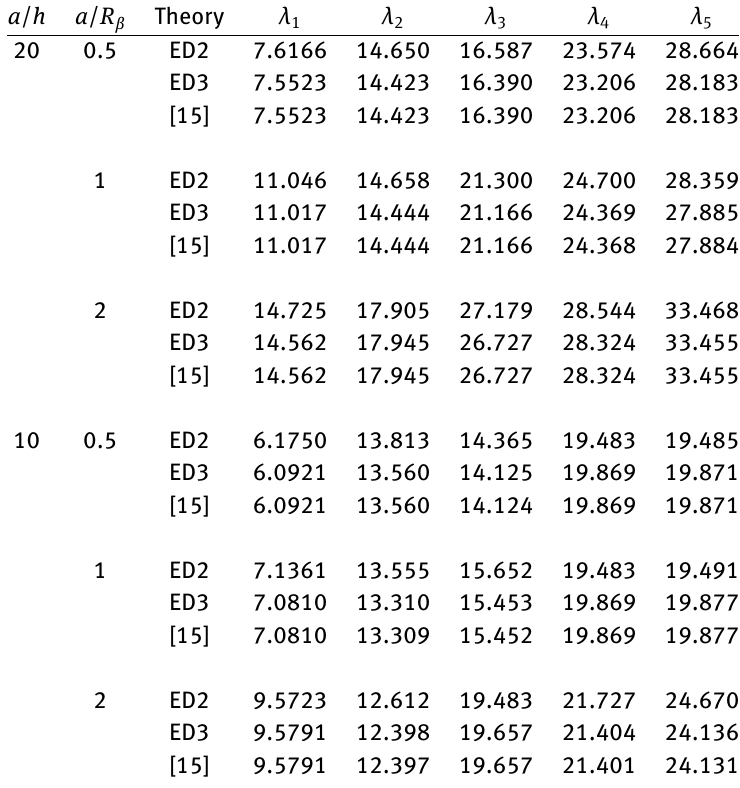
√︁ ρ of isotropic SSSS square cylindrical panels ( ν = 0.25 ). E